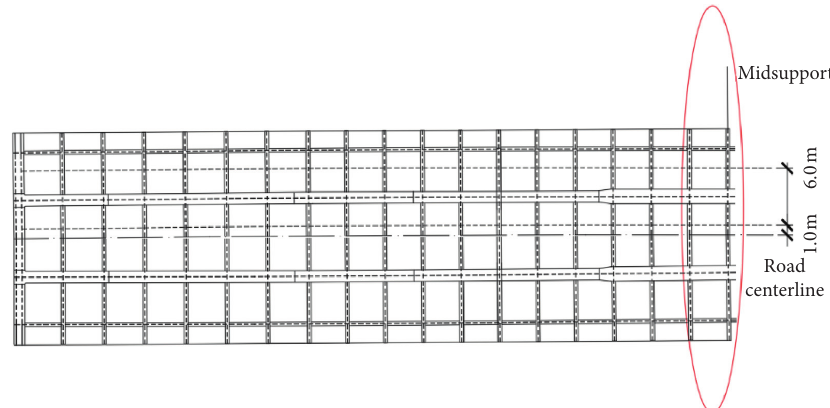
Figure 13: Checking the calculation position of the bridge deck in the negative-bending moment area.